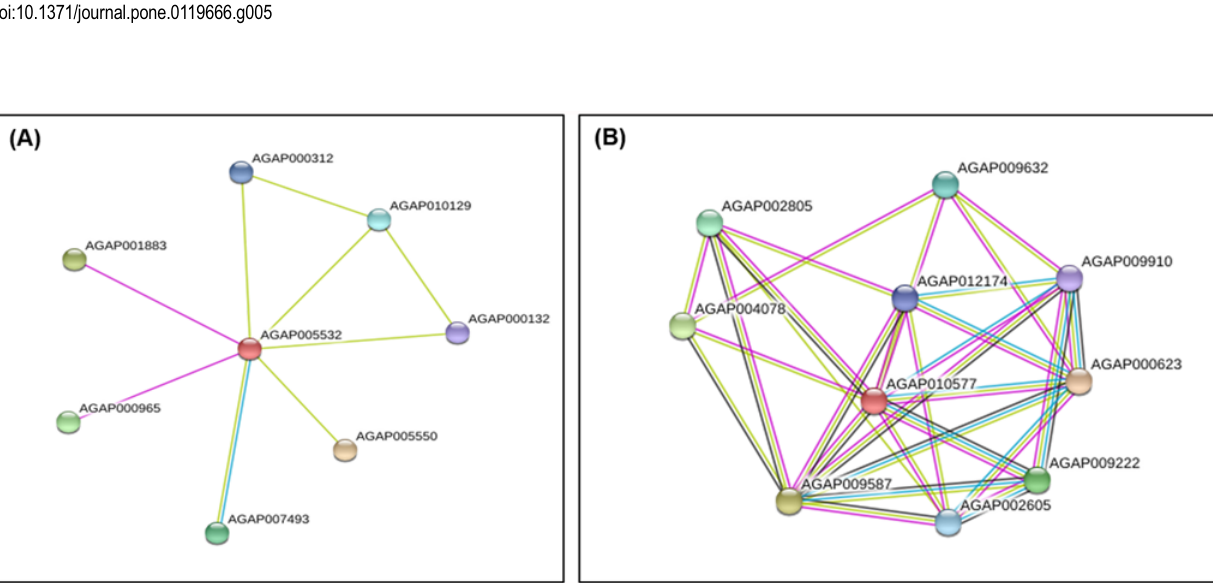
PLOS ONE | DOI:10.1371/journal.pone.0119666 March 5, 2015 12 /